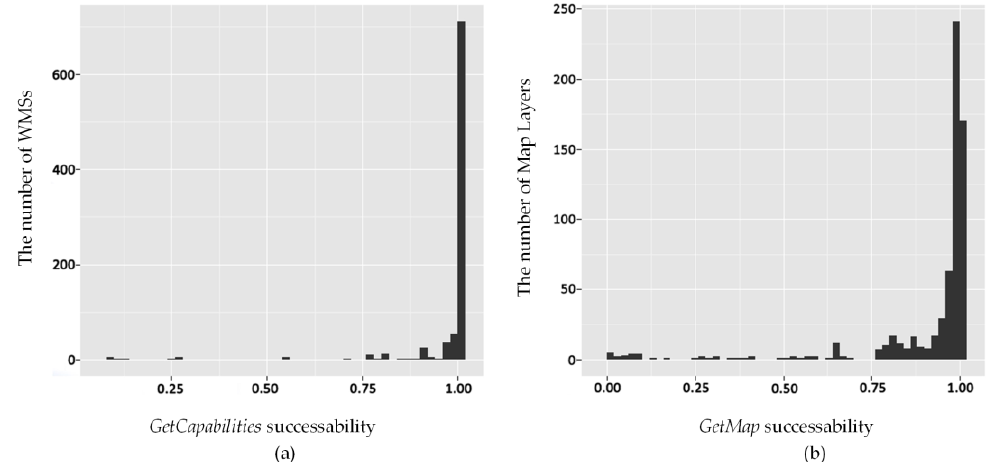
Table 4. Accessibility of GetCapabilities and GetMap operations.